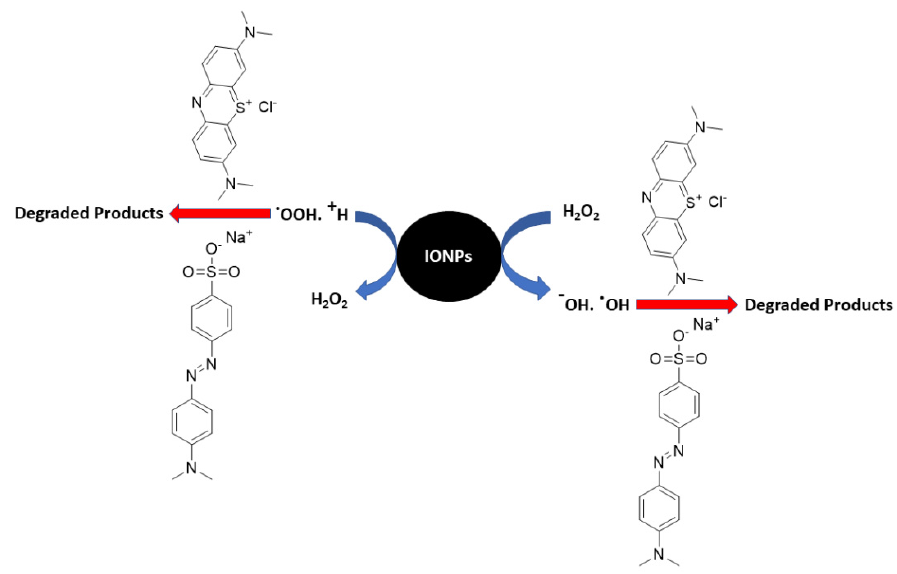
Figure 1. Mechanism of Fenton’s process by IONPs in degradation of MB and MO.